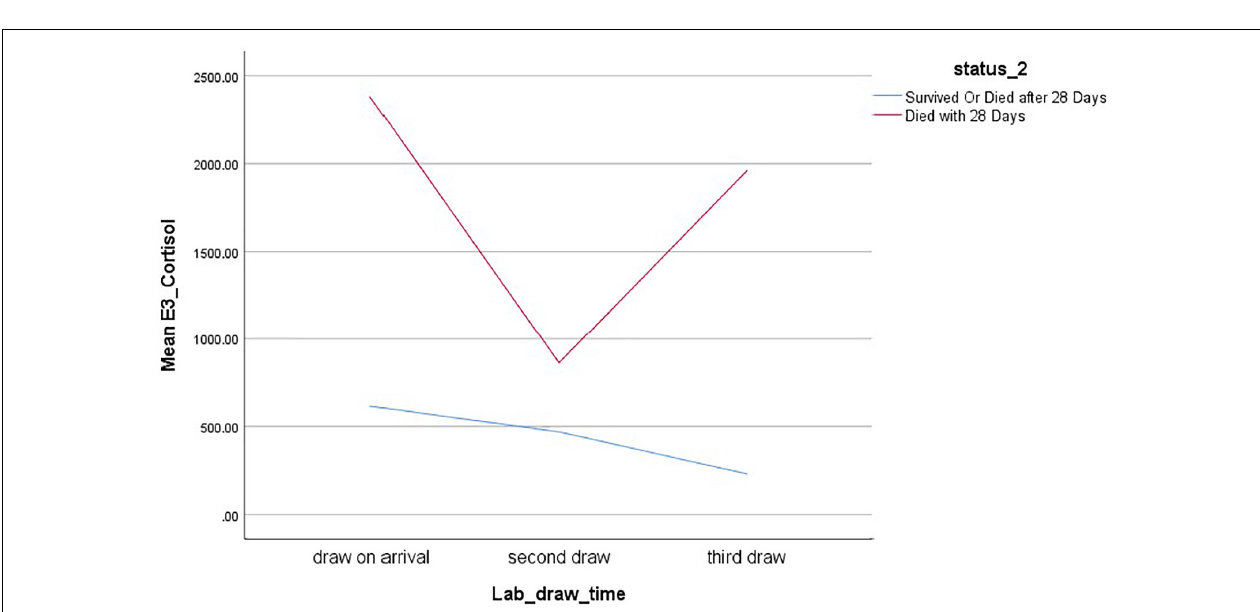
FIGURE 4 | Mixed model analysis of Cortisol index adjusted (no units), time of blood draw, and survival.